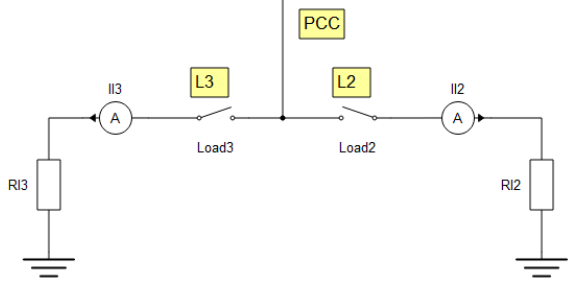
Figure 15. Low-priority loads experiment